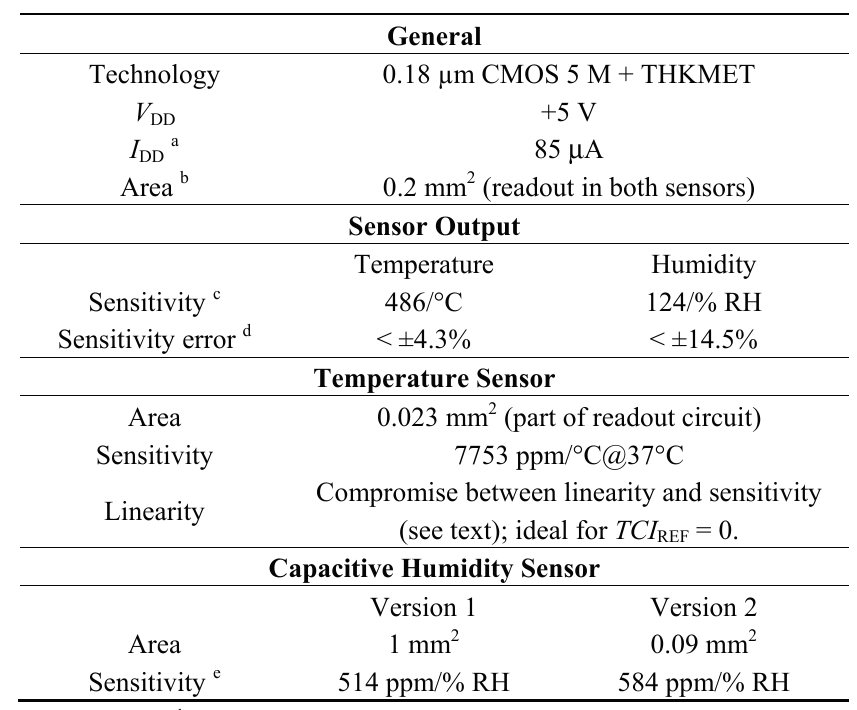
Table 1. Summary of performance.